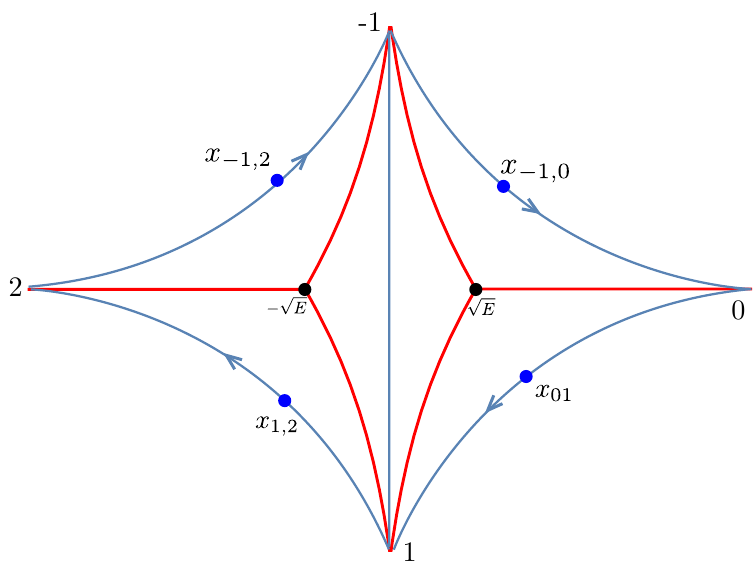
Figure 2 . WKB diagram for the differential equation (3.27) defined in (3.33). Generic flow lines and WKB lines are colored blue and red